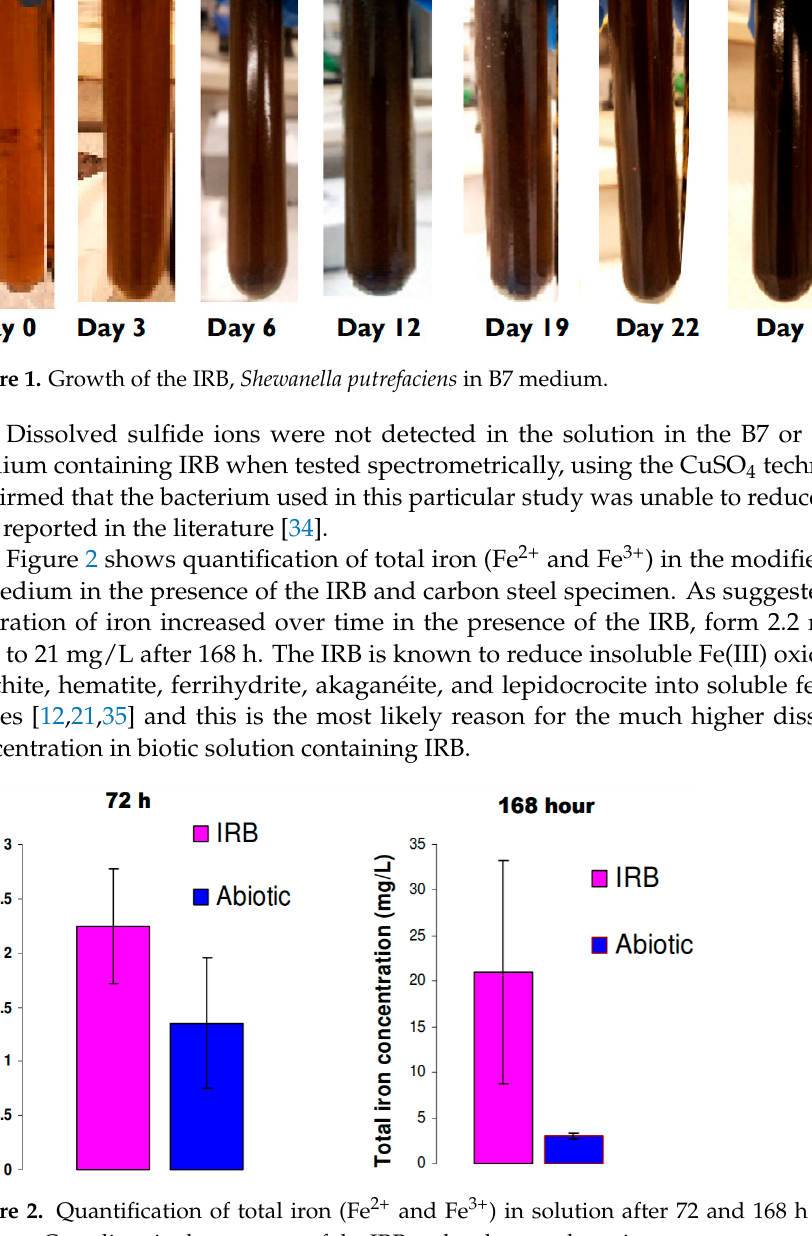
Figure 2. Quantification of total iron (Fe 2+ and Fe 3+ ) in solution after 72 and 168 h in modified Postgate C medium in the presence of the IRB and carbon steel specimen. Postgate C medium in the presence of the IRB and carbon steel